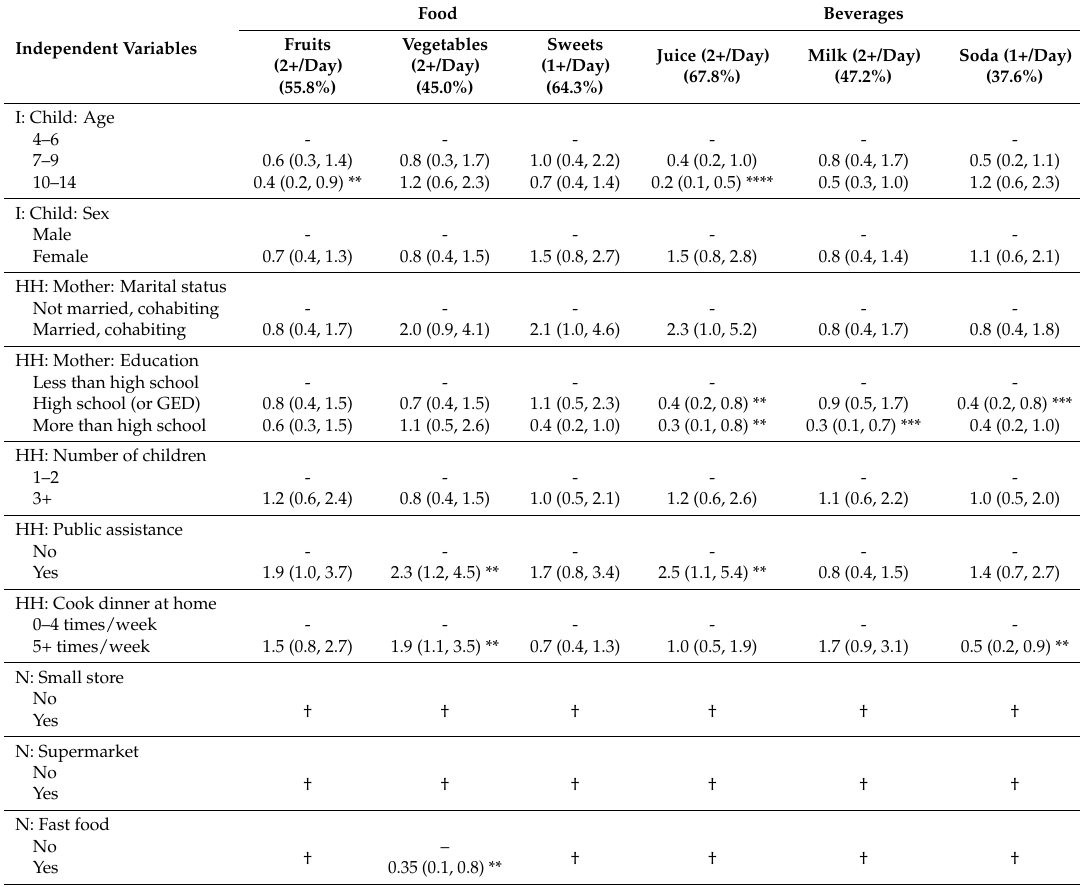
Table 2. Impact of the neighborhood food environment on food consumption: Multivariate model (adjusted odds ratios, 95% confidence interval) ( N =